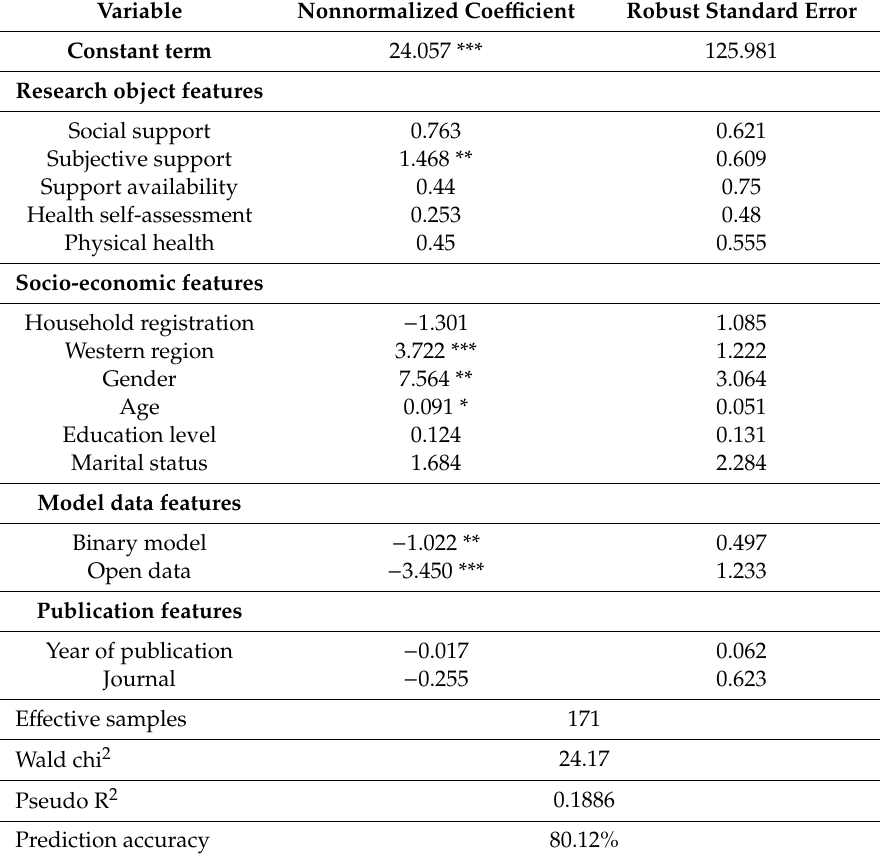
Table 3. Estimation results of meta-regression logit